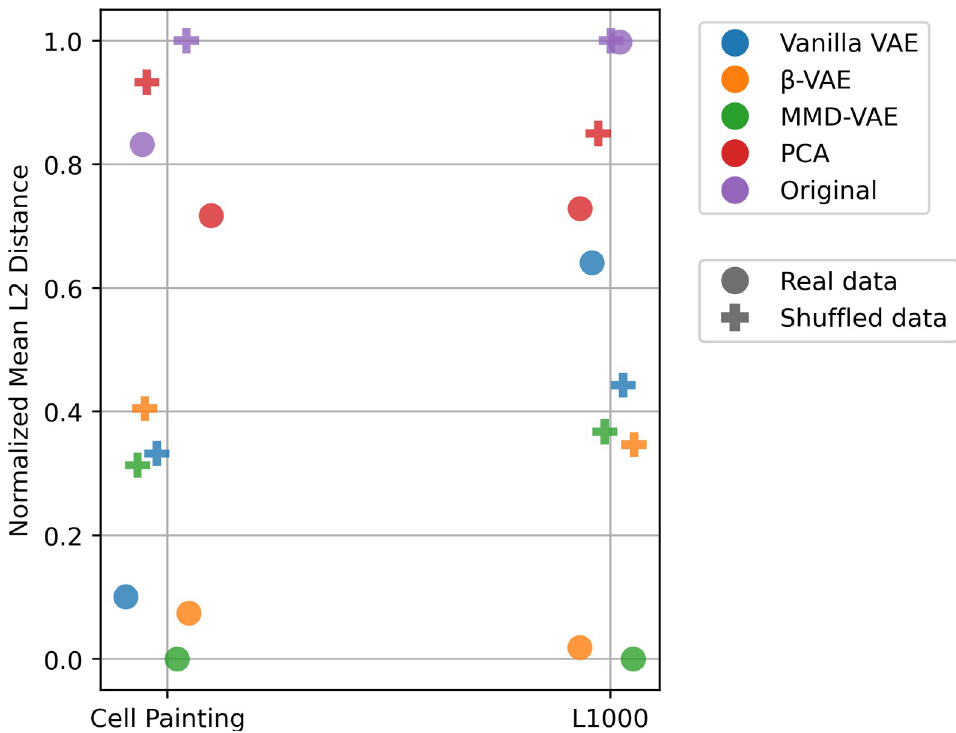
Fig 4. Mean L2 distance (lower is better) between real and predicted profiles annotated with known polypharmacology (“A \ B”) mechanisms of action (MOAs) for three different VAE architectures, PCA, and original input space. We show results for real and shuffled data across the two LINCS datasets. To enable a more meaningful and interpretable view, we zero-one normalized the L2 distances for each dataset. Each dot represents the mean L2 distance (values are normalized within each dataset) when LSA is performed using a specific model on a specific dataset.